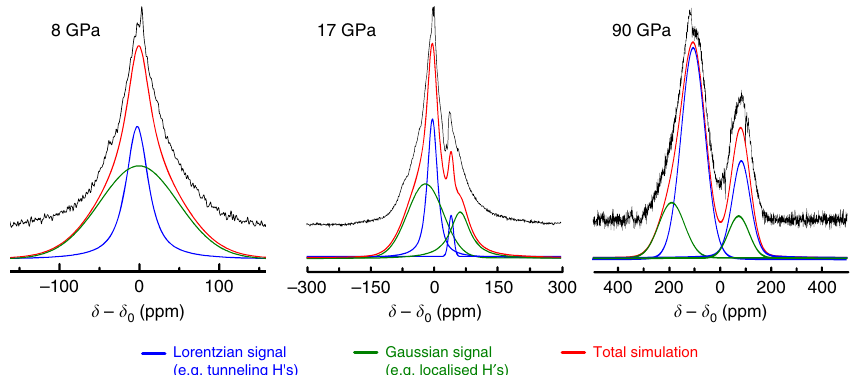
Fig. 4 Results of the deconvolution of three 1 H-NMR spectra (solid black lines) at pressures of 8, 17 and 90 GPa Lorentzian (blue) and Gaussian (green) contributions as well as the resulting total simulation (red) are shown